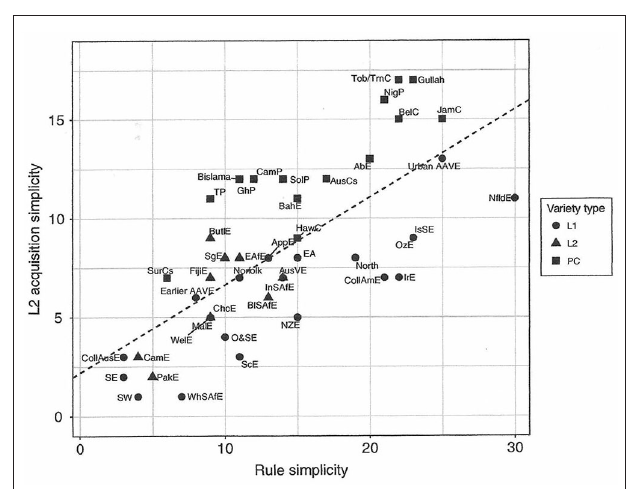
FIGURE 26 | Szmrecsanyi and Röthlisberger’s simple vs. simplifying varieties among for world Englishes (from Szmrecsanyi and Röthlisberger, 2020, p.